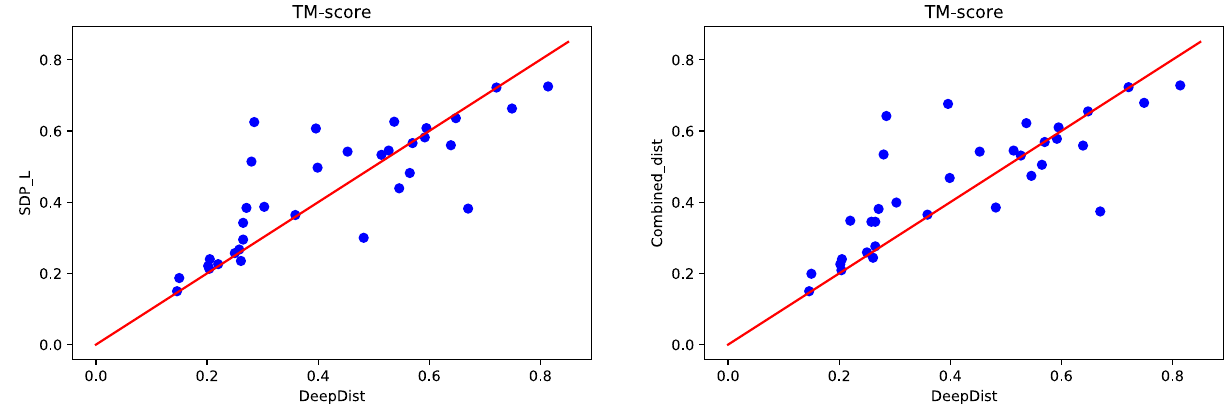
Figure 6. TM-scores of the protein structures obtained by using distace maps predicted by DeepDist and (left) that predicted by SDP-L and (right) that obtained by combining predicted distance maps of DeepDist and SDP-